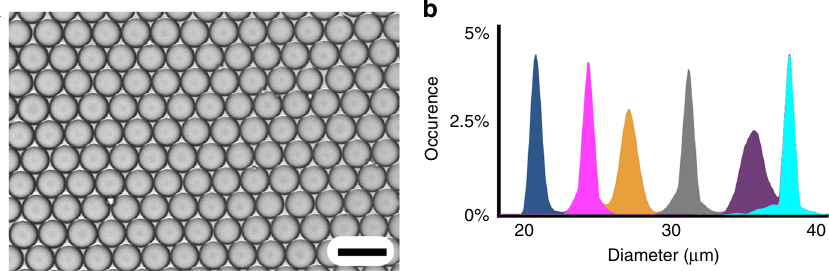
Fig. 3 High-throughput production of highly monodisperse hexadecane droplets from Dev III-VLSDI. a An optical image of hexadecane droplets with d = 22.5 µ m (CV = 3.30%) at Φ d = 7.30 L h − 1 . b The droplet diameter could be controlled by varying the fl ow rate of the dispersed and continuous phase fl uids. Droplets were produced over a range of d = 22.5 – 37.5 μ m, all with CV ~3%. The dispersed phase Φ water with 2 wt% Tween 80. Blue: d = 22.5 µ m, CV = 3.30%, Φ d = 7.30 L h − 1 , Φ c = 9.20 L h − 1 ; magenta: d = 25.5 µ m, CV = 2.30%, Φ d = 0.40 L h − 1 , Φ c = 5.60 L h − 1 ; orange: d = 28.5 µ m, CV = 2.92%, Φ d = 4.00 L h − 1 , Φ c = 6.25 L h − 1 ; gray: d = 31.6 µ m, CV = 2.62%, Φ d = 1.00 L h − 1 , Φ c = 2.80 L h − 1 ; purple: d =